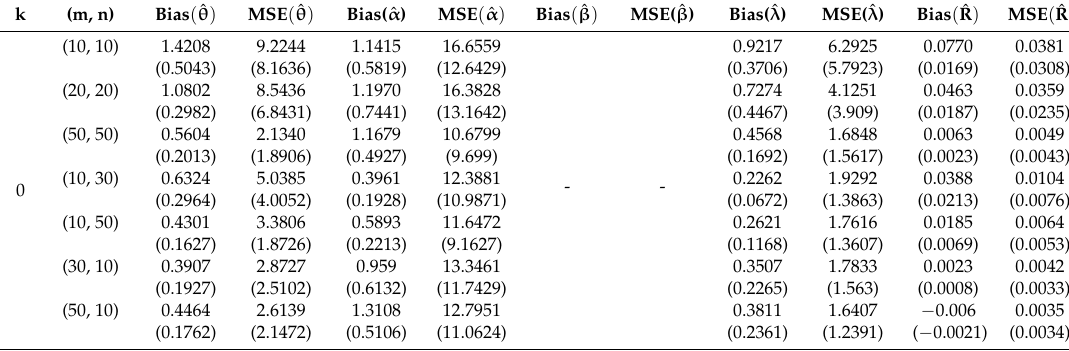
Table 2. Average Bias and MSEs for ( ˆ θ , ˆ α , ˆ β , ˆ λ , ˆ R ) ( λ is unknown, λ = 2, α = 7, β = 5, θ =